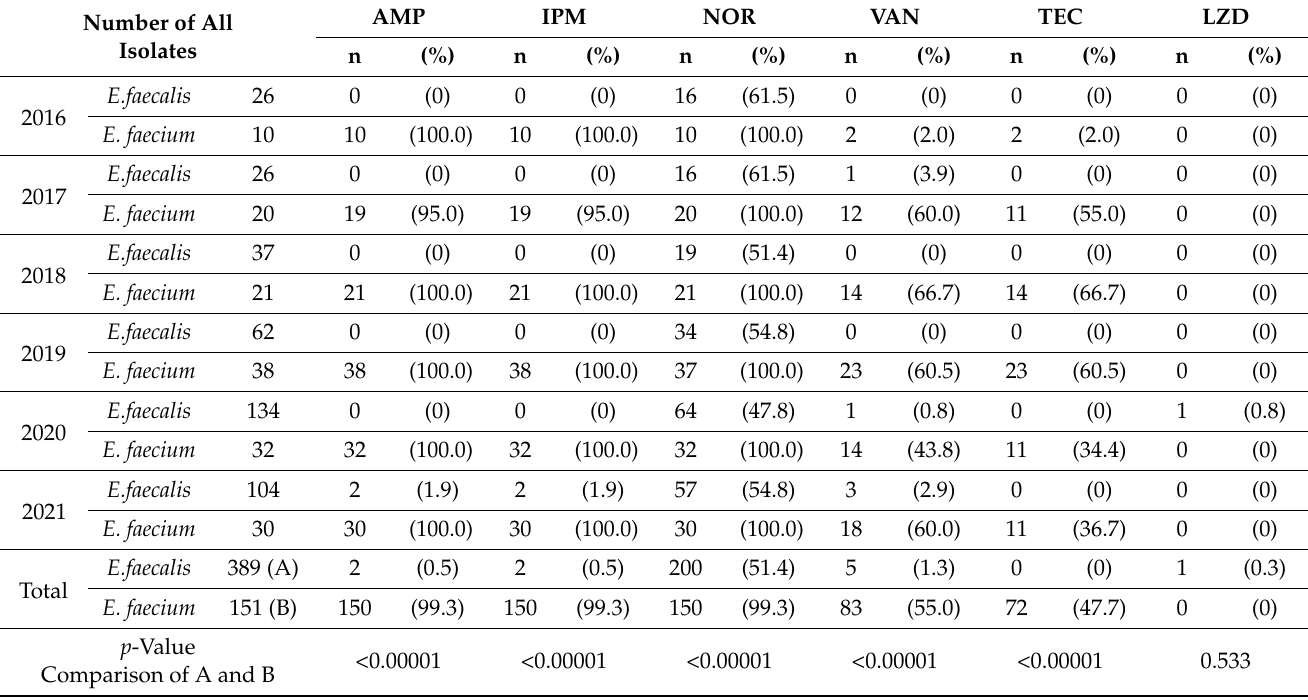
Table 3. Percentage of antimicrobial resistance of E. faecalis and E. faecium strains isolated from the urine of patients hospitalized in Nephrology and Urology Clinics and their species distribution divided into years 2016–2021.